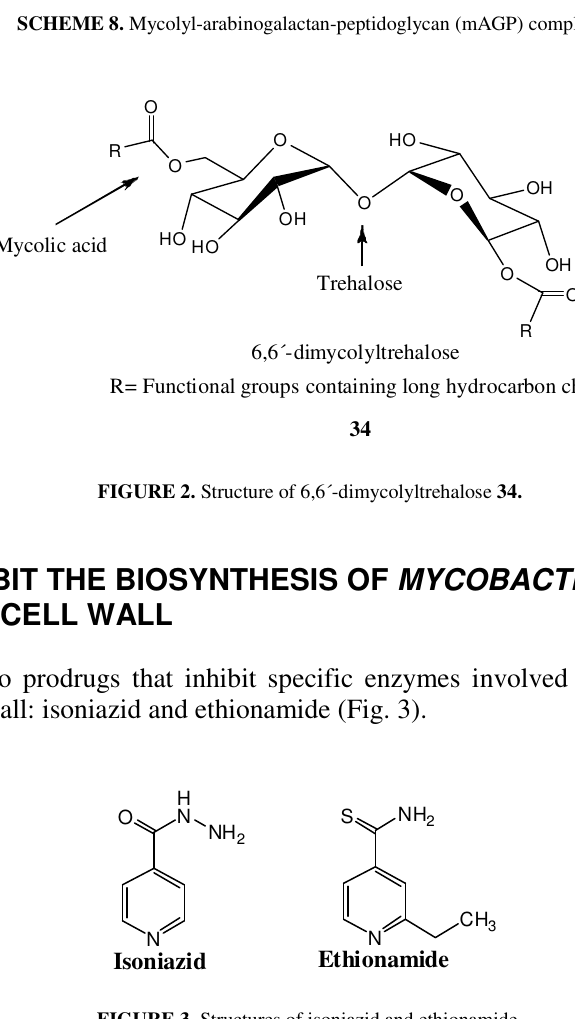
FIGURE 3. Structures of isoniazid and